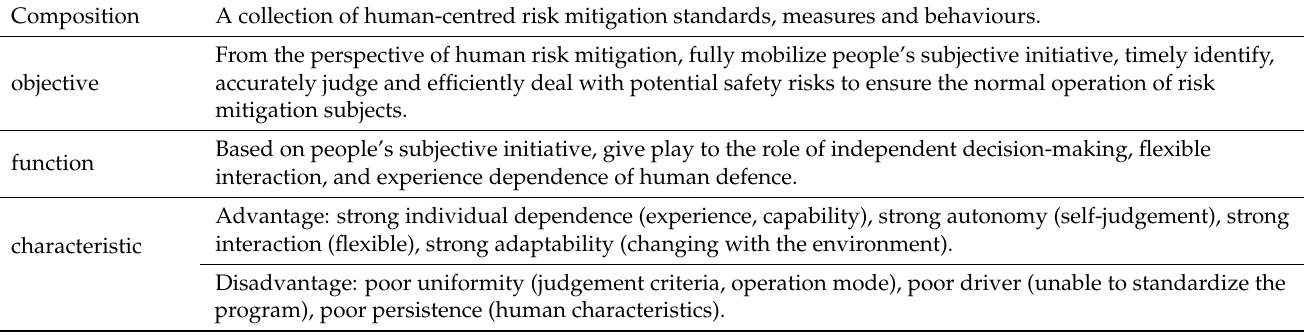
Table 1. Details of the human defence subsystem of the